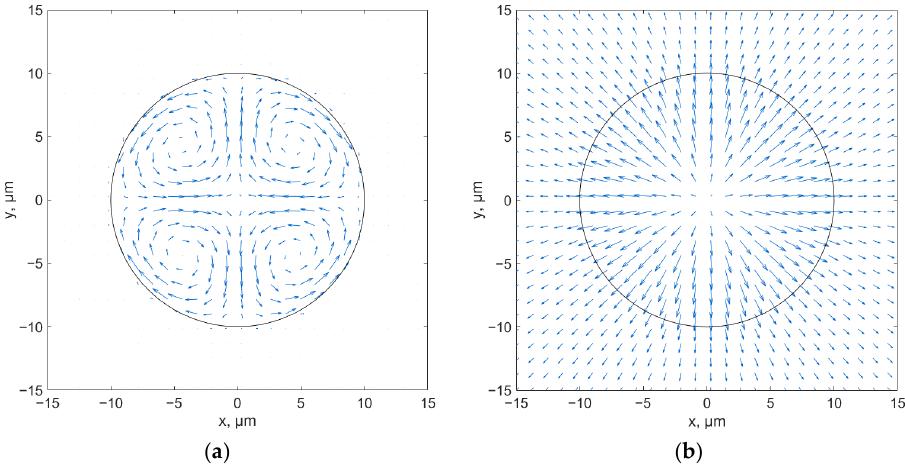
Figure 1. Spin ( a ) and orbital ( b ) parts of the transverse component of the Poynting vector of the fundamental core mode of a dielectric pipe in the case of linear polarization. The refractive index of the pipe core is 1.45 and the refractive index of the surrounding medium is 1.5. The pipe core diameter is 20 µm and the wavelength is 1 µm.